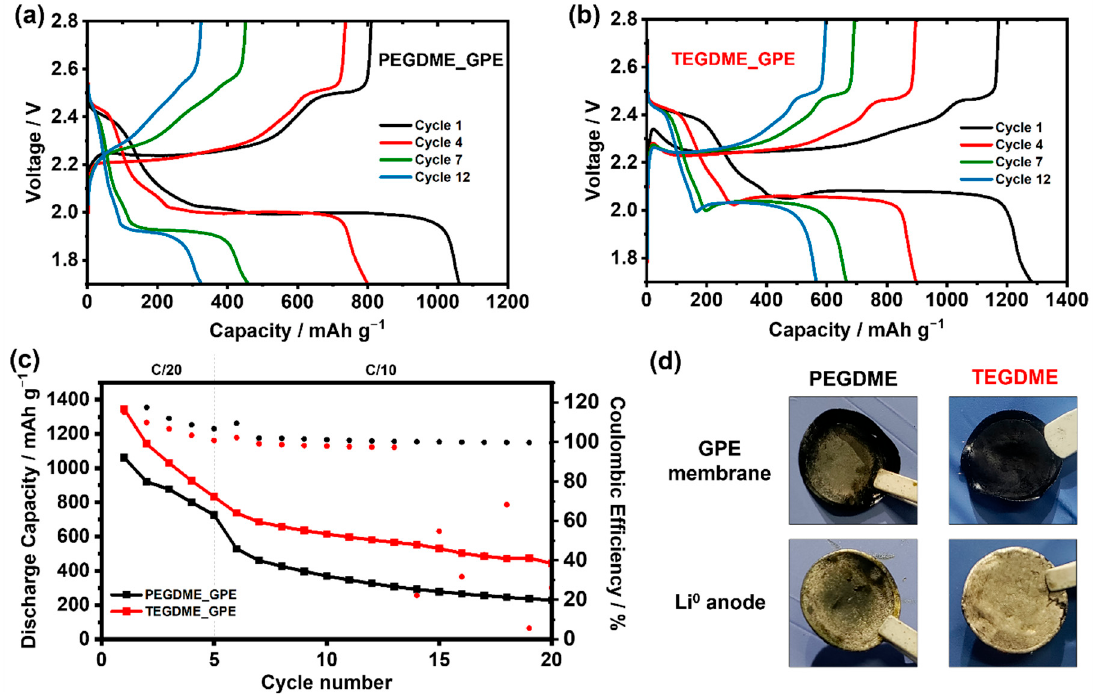
Figure 3. ( a , b ) Charge/Discharge profiles for PEGDME_GPE and TEGDME_GPE Li-S cells, respec- tively. ( c ) battery performance of developed GPEs. ( d ) Optical post-mortem images of the analyzed GPEs and their corresponding Li 0 anode.